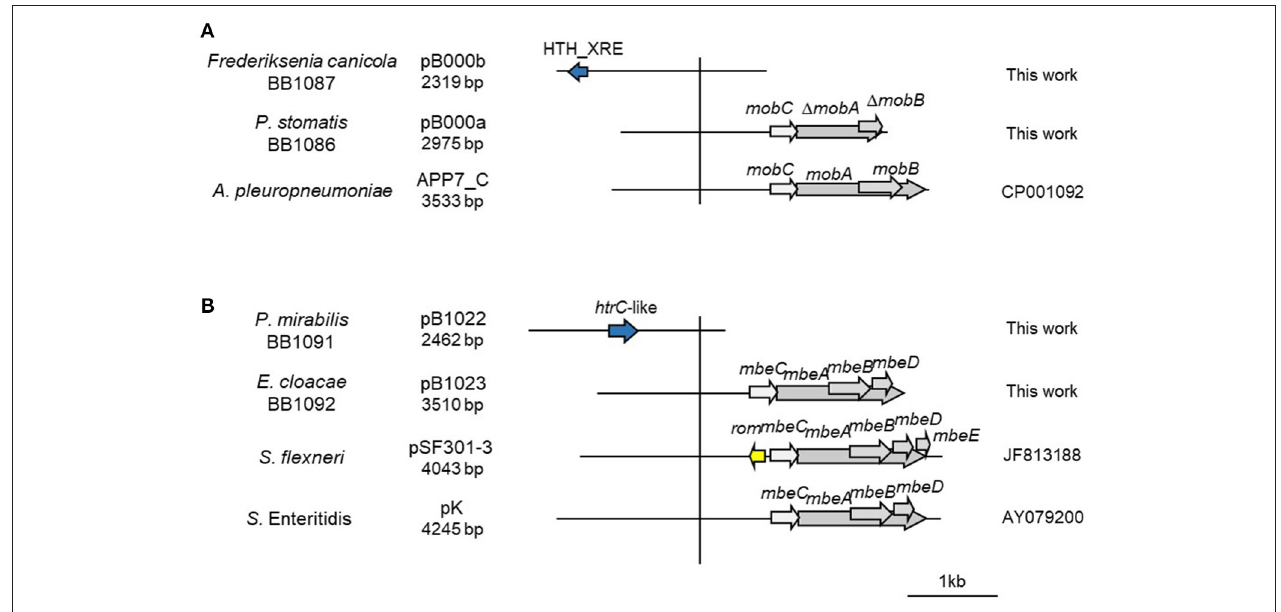
FIGURE 4 | Genetic structure of a selection of ColE1 cryptic plasmids. Schematic diagram of ColE1 cryptic plasmids from Pasteurellaceae (A) and Enterobacteriaceae (B) . The reading frames for genes are shown as arrows, with the direction of transcription indicated by the arrowhead. Genes encoding plasmid relaxases are shown in gray. The vertical bar separates the conserved region of the plasmids, to the right, from the variable region of the plasmids, to the left. The species in which the plasmid has been described, and the name, size, and accession number of plasmids are also